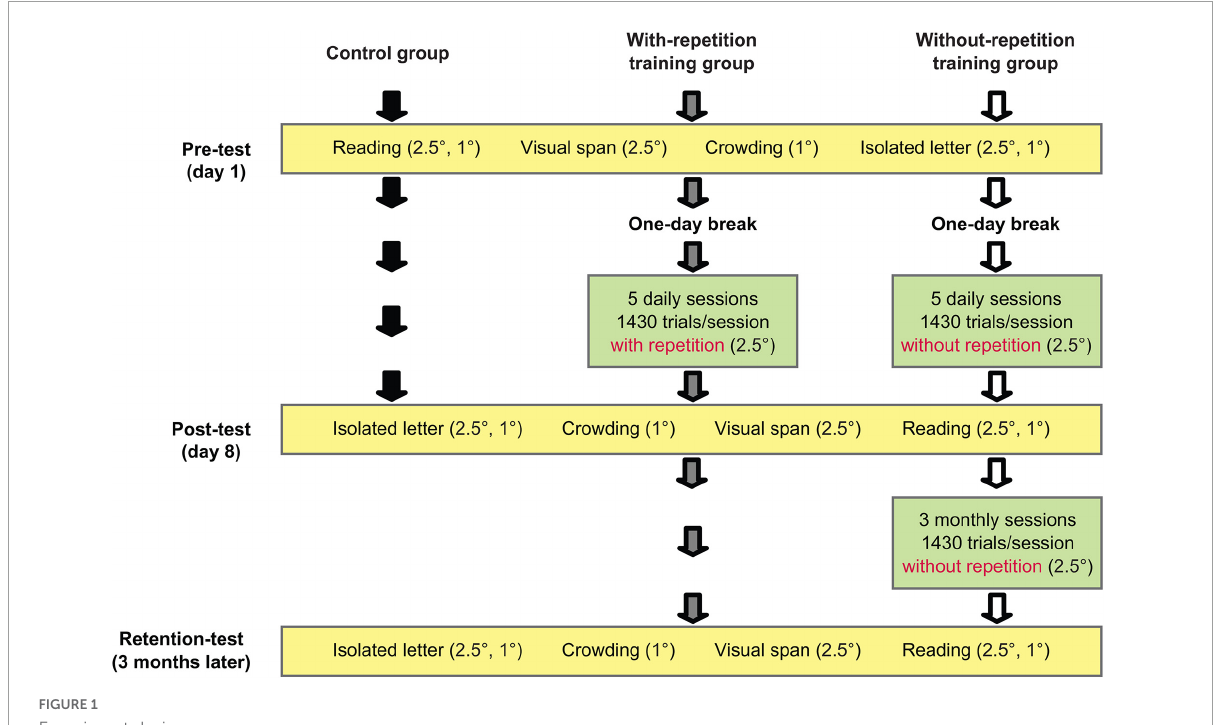
FIGURE1 Experiment